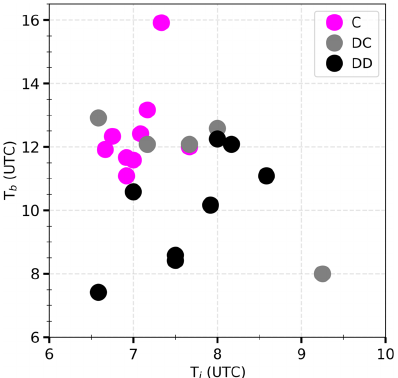
Figure 11. LLSC breakup time ( T b ) against surface-convection in- fluence time ( T i ) for the 22 selected cases (Table A1). The colors represent the three different